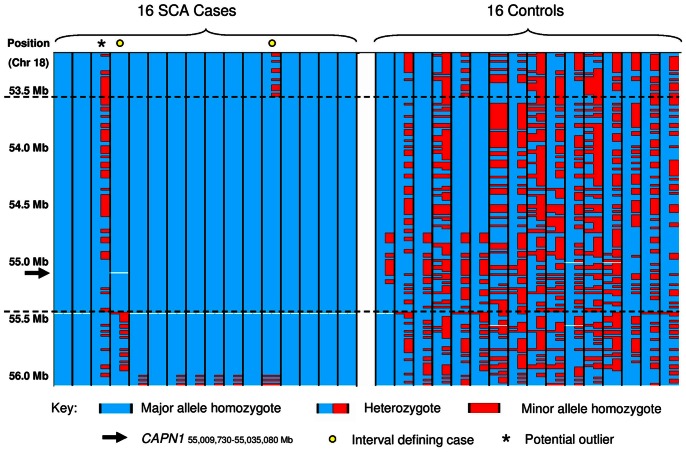
Raw genotyping data across the disease associated region for SCA.Graphical overview of the raw genotyping data across the SCA critical region. Each column represents one individual, and SNP markers are listed in the rows with the approximate position indicated. Major alleles are highlighted in blue and minor alleles in red. Interval defining cases are marked by a circle at the top of individual columns. The outlying case which does not share the disease associated haplotype across the interval is marked with an asterisk.